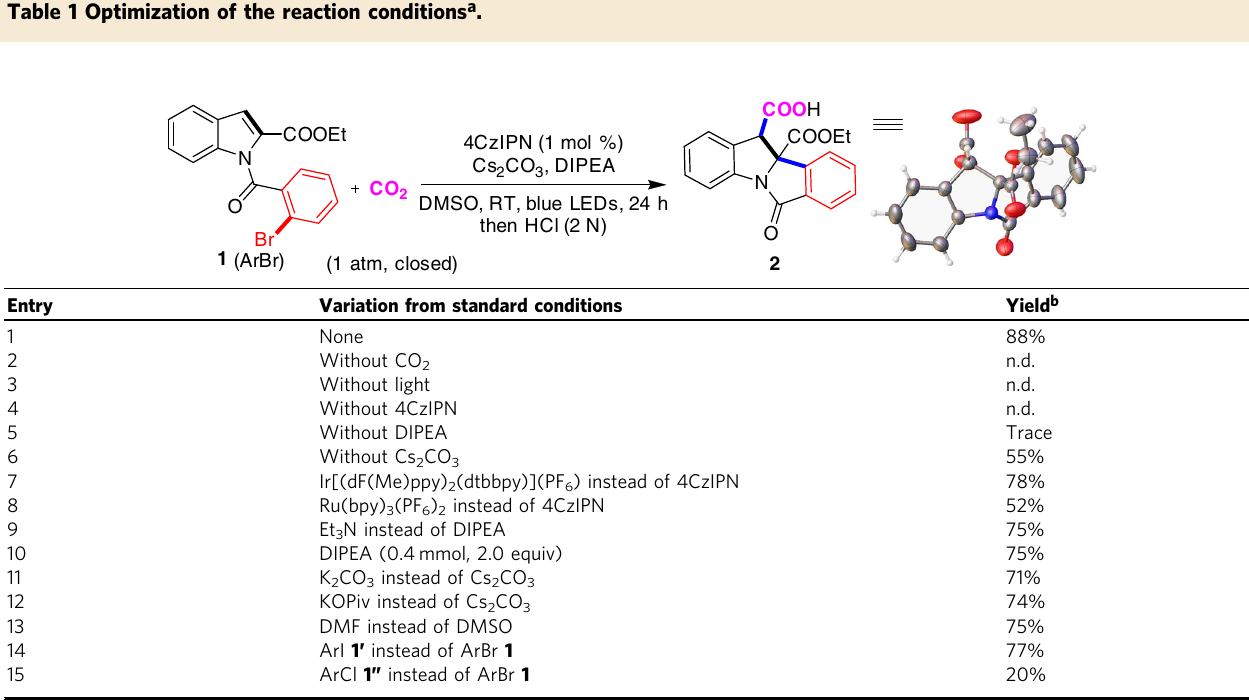
Table 1 Optimization of the reaction conditions a